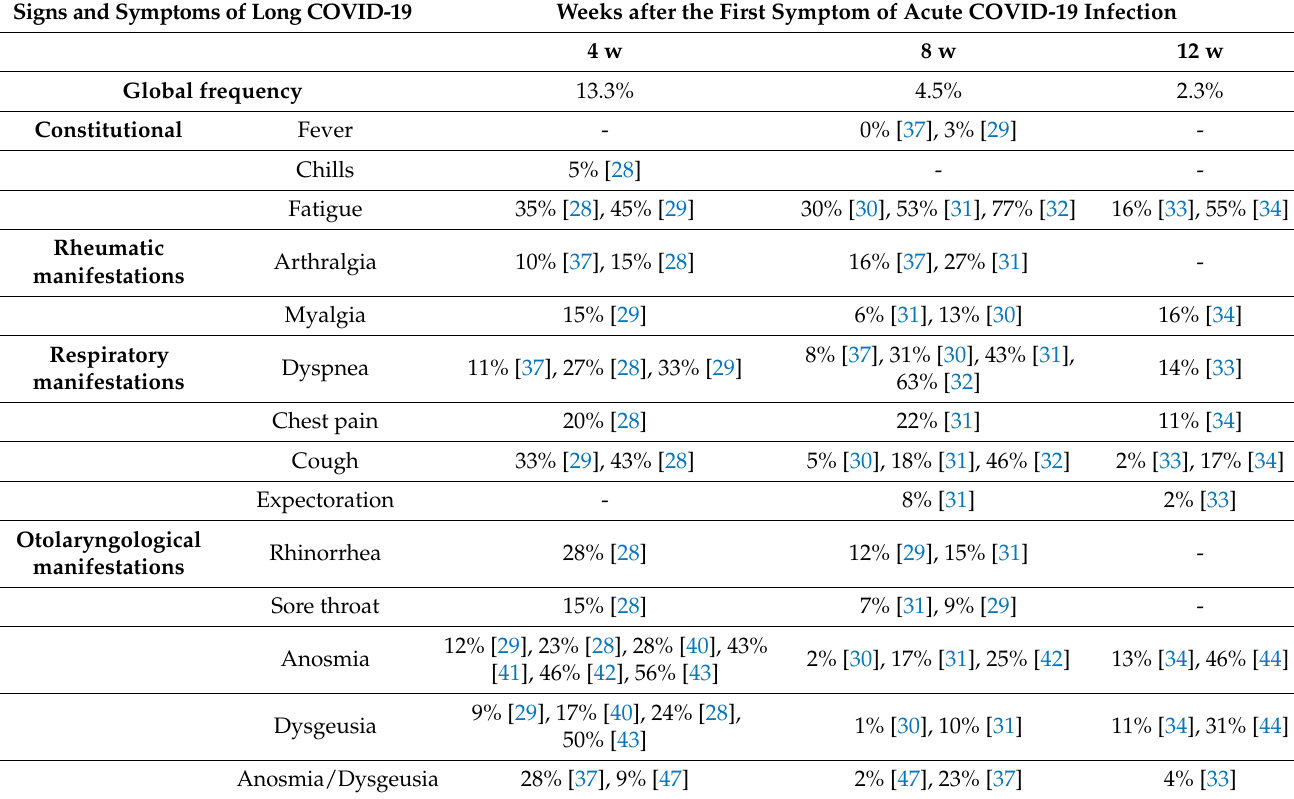
Table 3. Summary of data from the main studies on symptoms reported as long COVID-19 (>4 w) * [28–34,37,40–44,47]. Signs and Symptoms of Long COVID-19 Weeks after the First Symptom of Acute COVID-19 Infection 4 w 8